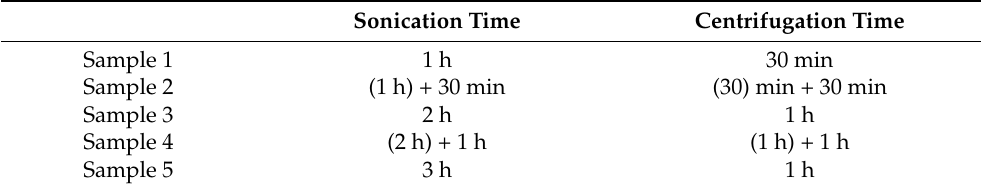
Table 1. Summary of Samples and their corresponding sonication and centrifugation times. Samples 2 and 4 are obtained after the re-exfoliation of previous Samples 1 and 3,